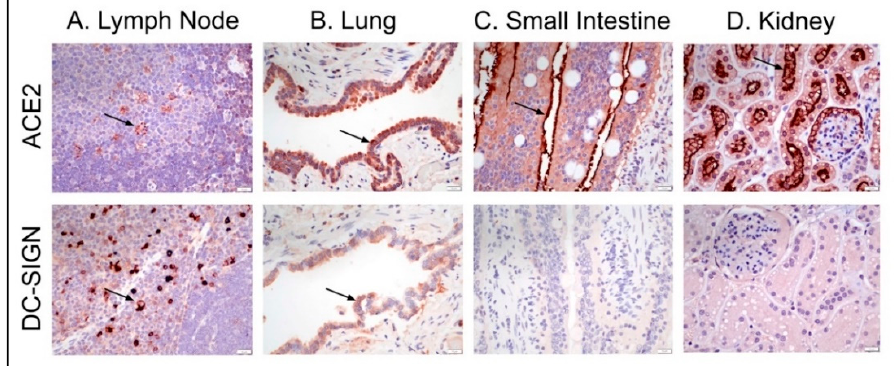
Figure 5. ACE2 and DC-SIGN immunohistochemistry panel of representative tissues. Brown im- munostaining represents antigen detection of either ACE2 or DC-SIGN (arrows denote examples of antigen detection). ( A ) Scattered cells with antigen detection for ACE2 in lymphoid follicle germinal centers and paracortex for DC-SIGN. ( B ) Bronchiolar epithelial antigen detection for ACE2 and weaker signal detected for DC-SIGN. ( C ) Small intestinal villous epithelial antigen detection for ACE2, particularly along the apical aspect of epithelial cells and absent antigen detection for DC- SIGN. ( D ) Strong antigen detection for ACE2 within renal cortex tubular epithelium for ACE2 and absent antigen detection for DC-SIGN. 3.4. RNAseq Gene Expression Profiles of FCWF-4 ATCC and FCWF-4 CU Cell Lines